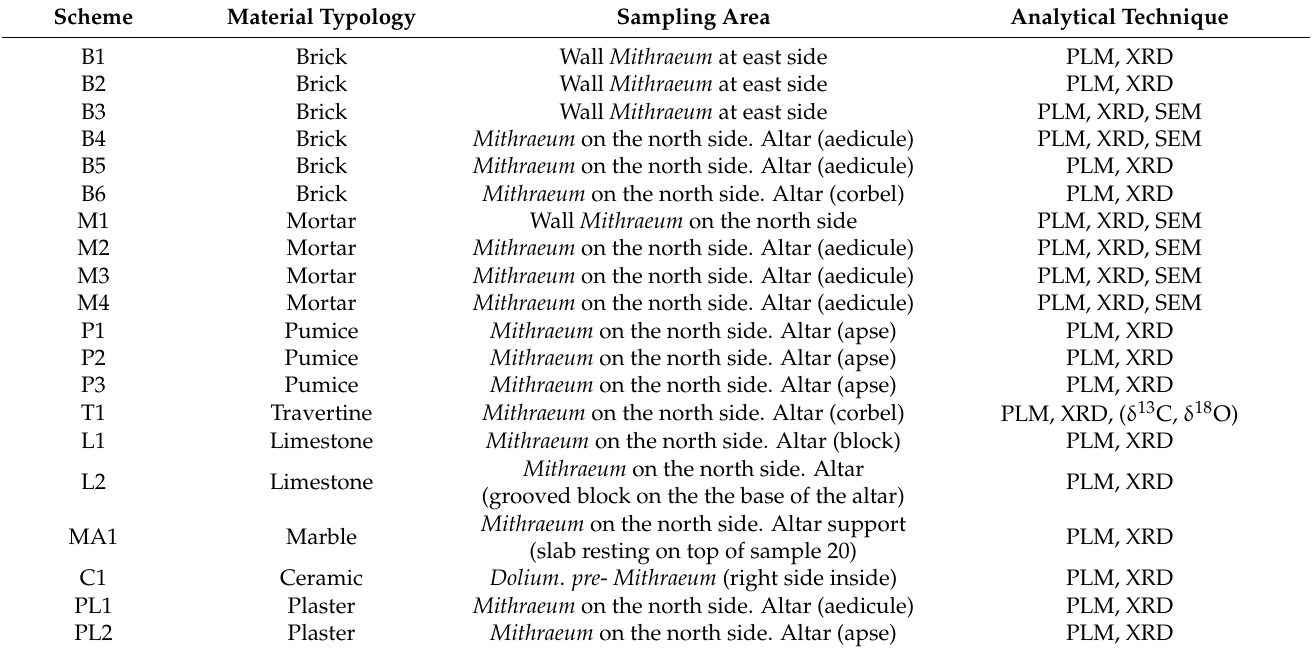
Table 1. Typology, sites of sampling and analytical methods carried out. The analytical methodologies are listed with abbreviations. PLM: Polarized Light Microscope; XRD: X-ray Diffraction; SEM: Scanning Electron Microscope.